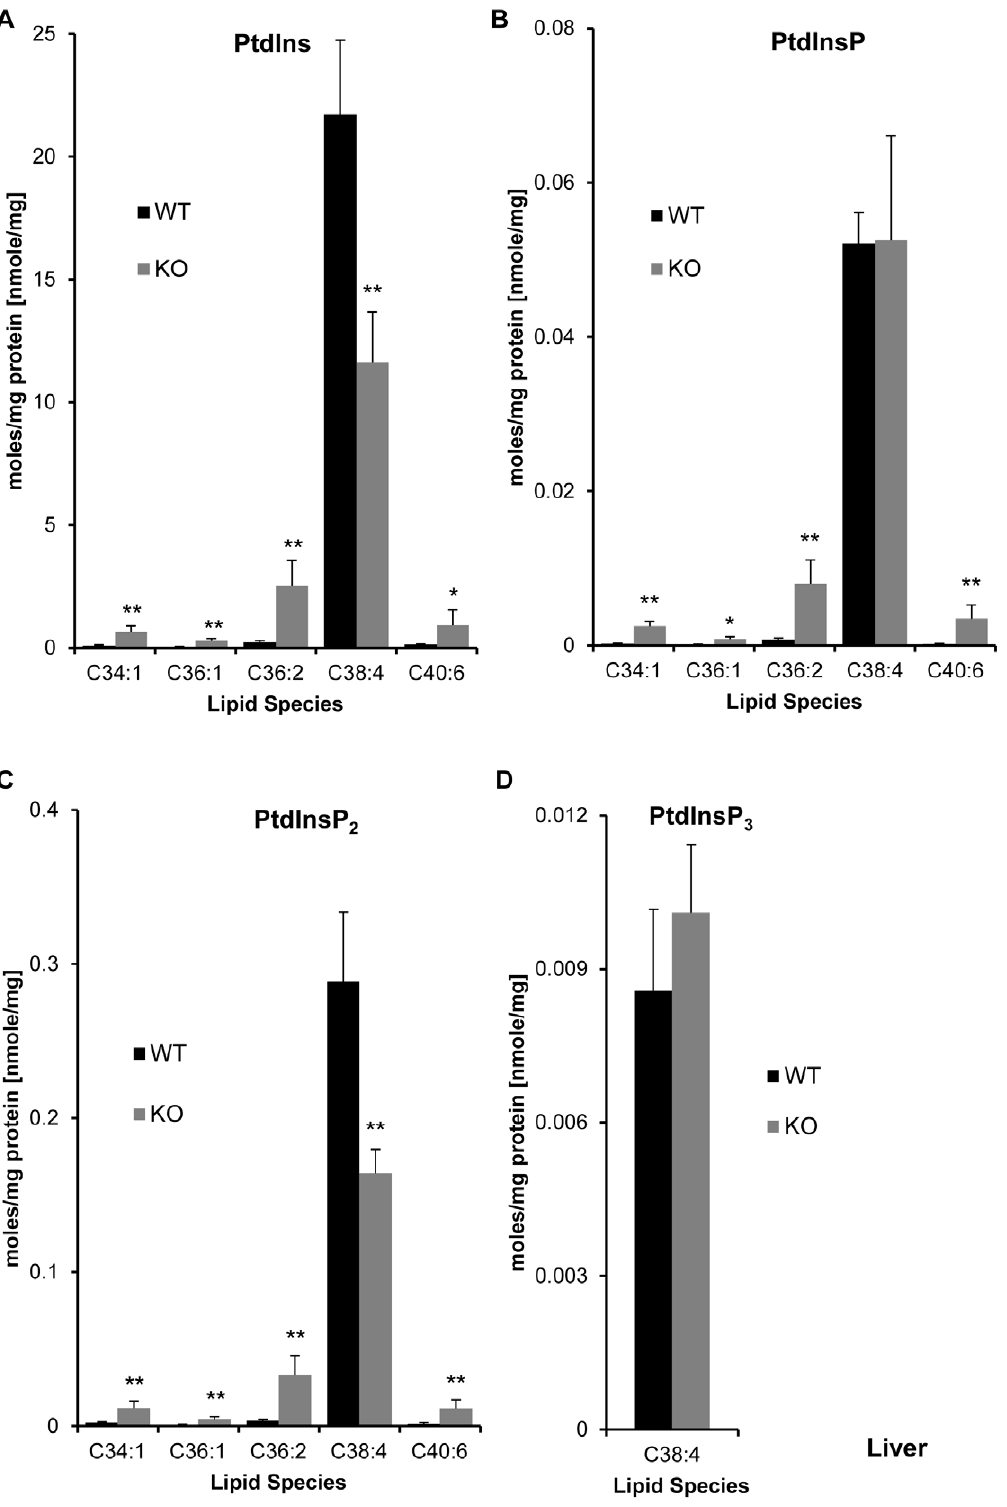
Figure 3. Effect of LPIAT1 knockout on liver phosphoinositide lipid molecular species. Livers from 13 day old littermates expressing (LPIAT1 + / + (WT)) or lacking (LPIAT1 2 / 2 (KO)) LPIAT1 were homogenized and lipids extracted from 0.5 mg wet weight as described in Materials and Methods. Targeted molecular species of PtdIns ( A ), PtdInsP ( B ), PtdInsP 2 ( C ) and PtdInsP 3 ( D ) were detected by MRM mass spectrometric analysis as described in Materials and Methods. Data are expressed as moles/mg protein, normalized to relevant internal standards. Shown are mean 6 SD, n=4 for both WT and KO. Data were analyzed by T-test. *p # 0.05, **p # 0.005.